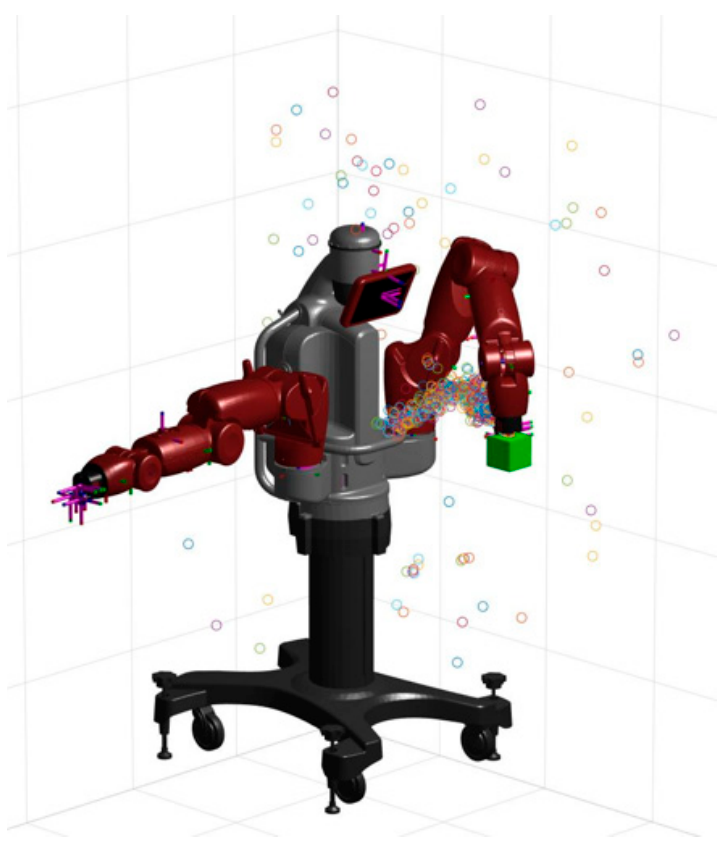
Figure 10. Motion of the particle swarm.